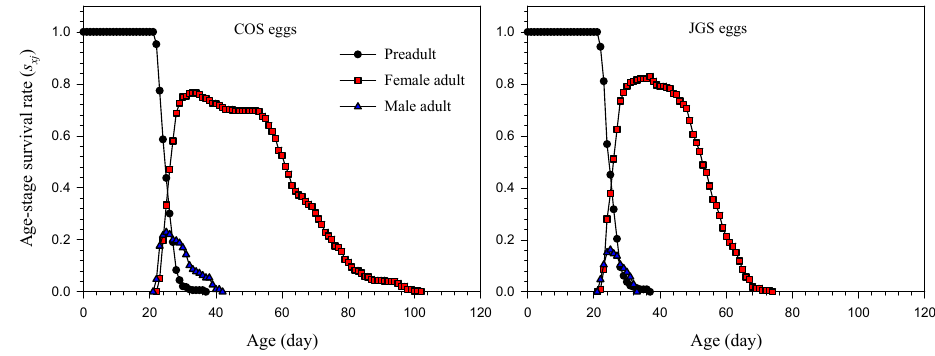
Figure 1. Age-stage survival rate ( s xj ) of Anastatus japonicus parasitizing COS and JGS eggs. The age-specific survival rate ( l x ), age-specific fecundity ( f x 2 ), age-specific fecundity of population ( m x ), and age-specific net reproductive rate ( l x m x ) of A. japonicus parasitizing COS eggs and JGS eggs were illustrated on Figure 2. The l x was higher on the JGS than COS eggs from 36 to 47 days of age. The highest m x was 12.80 at the age of 42 days on the COS eggs or 10.54 at the age of 35 days on the JGS eggs. Both the m x and l x m x decreased gradually on COS and JGS eggs (after 42 and 35 days old, respectively), except that the m x increased again from 79 to 82 days of age and then decreased again on the COS eggs. The ages at which adult females reached 90% cumulative fecundity on COS eggs (256.45) and JGS eggs (135.03) were 61 and 47 days, respectively. Figure 2. Age-specific survival rate ( l x ), age-specific fecundity ( f x 2 ), age-specific fecundity of popu- lation ( m x ), age-specific net reproductive rate of population ( l x m x ), and cumulative fecundity of Anastatus japonicus parasitizing COS and JGS eggs. 3.3. Life Expectancy and Reproductive Value of A. japonicus Parasitizing COS and JGS Eggs The life expectancy values ( e xj ) of a newly laid A. japonicus egg on COS eggs and JGS eggs were 58.99 and 51.09 days, respectively (Figure 3). The highest e xj for the adult fe- males on COS eggs (43.63 days) was higher than that on JGS eggs (33.49 days) at 23 and 22 days of age, respectively. The highest e xj for the adult males on COS eggs (11.27 days) was also higher than that on JGS eggs (7.66 days) at the age of 22 days.